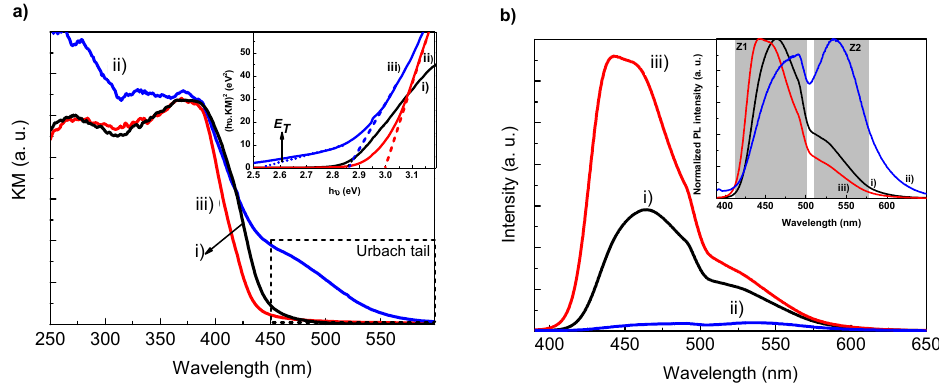
Figure 3. ( a ) DR UV–vis spectra (inset is shown the respective Tauc plots) and ( b ) PL spectra (inset is shown the normalized PL spectra) of (i) GCN, (ii) GCN-T-N, and (iii) GCN-T. Highlighted zones Z1 and Z2 indicate the two PL emission bands.